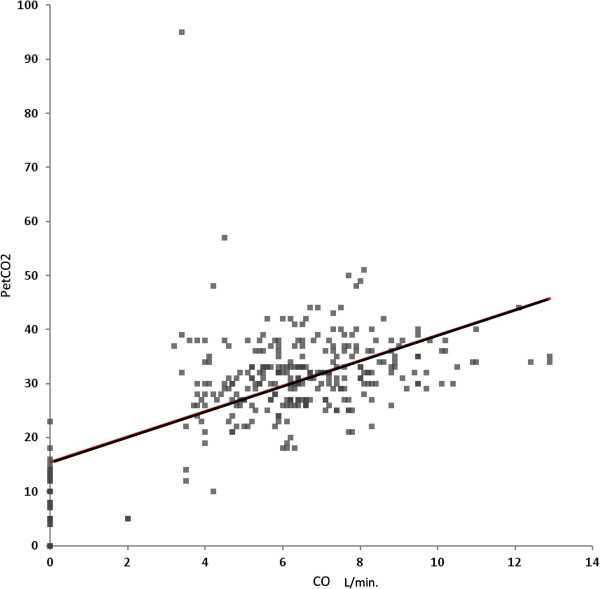
Scatter plot of cardiac output and PetCO2.